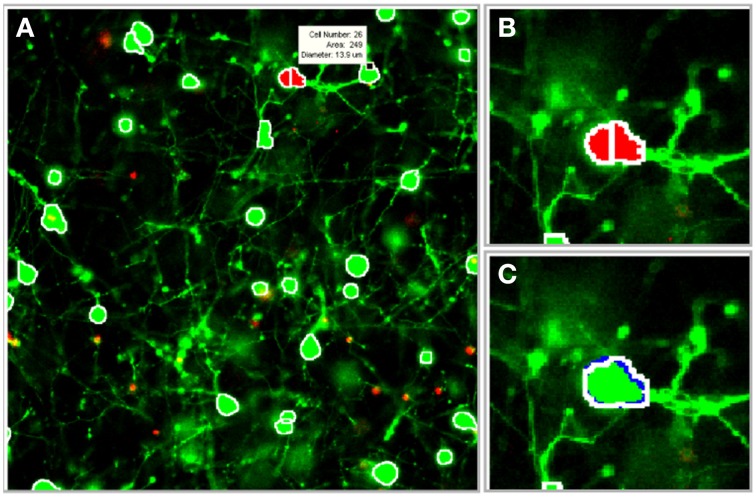
Illustration of software tools. The segmentation algorithms were integrated into a graphical user interface (GUI) to facilitate visual feedback, parameter selection, and software assisted error correction. (A) Segmentation boundaries (white) are projected onto individual frames in the z-stack (a scroll bar, not shown, is used to switch between frames). Segmentation data, including cell ID number, area, and diameter (white box), are displayed for a selected cell. (B) Potential segmentation errors are automatically flagged in red. (C) A user-applied mouse command instructs the software to perform a merge operation. Blue pixels outline the object in the forward adjacent z-slice/frame that is connected to the merged cell. (Gray pixels, not shown, indicate connected objects in the previous frame). Images were taken at 20×.